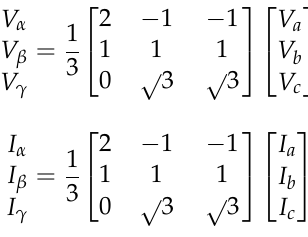
ferent timeframes and frequency bands for the high frequency and high resolution. In this regard, 𝐼 (cid:3028) , 𝐼 (cid:3029) , and 𝐼 (cid:3030) are separately differentiated to √3𝐼 cos∅(𝑡) , √3𝐼 sin ∅(𝑡), and 0,